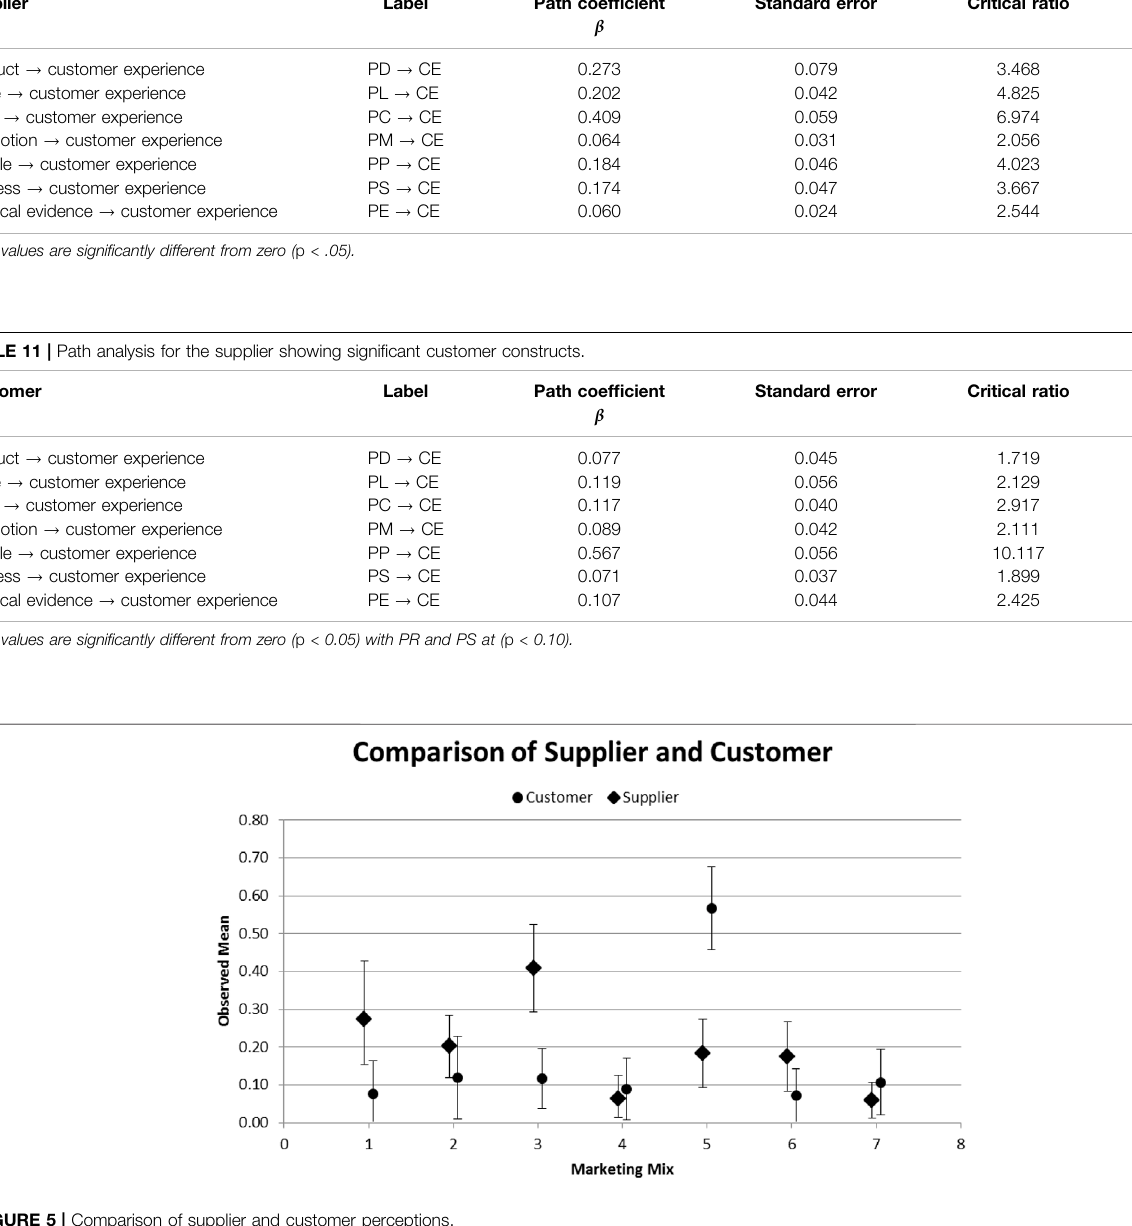
TABLE 10 | Path analysis for the supplier showing signi fi cant supplier constructs. Supplier